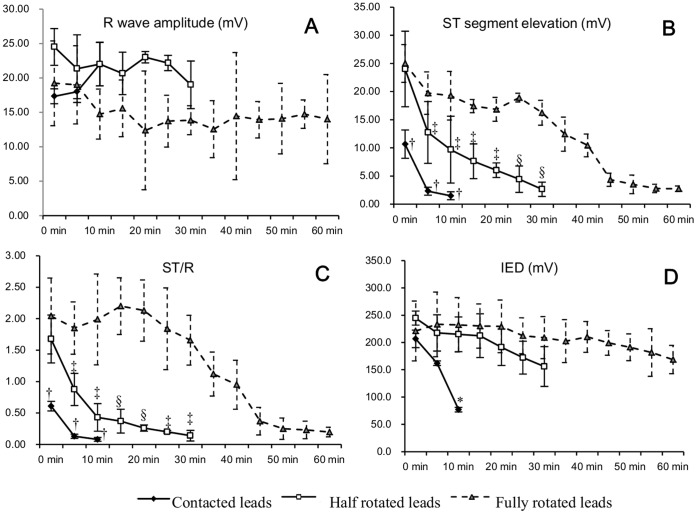
Comparison of Intracardiac EGM variables derived from in vivo hearts.Panel A, B and C showed the similar findings observed in Figure 3. Panel D. No difference in IED between half and fully rotated leads at any time point. *: p<0.05 and †: p<0.01 (compared with half and fully rotated leads); ‡: p<0.05 and: §: p<0.01 (compared with fully rotated leads).